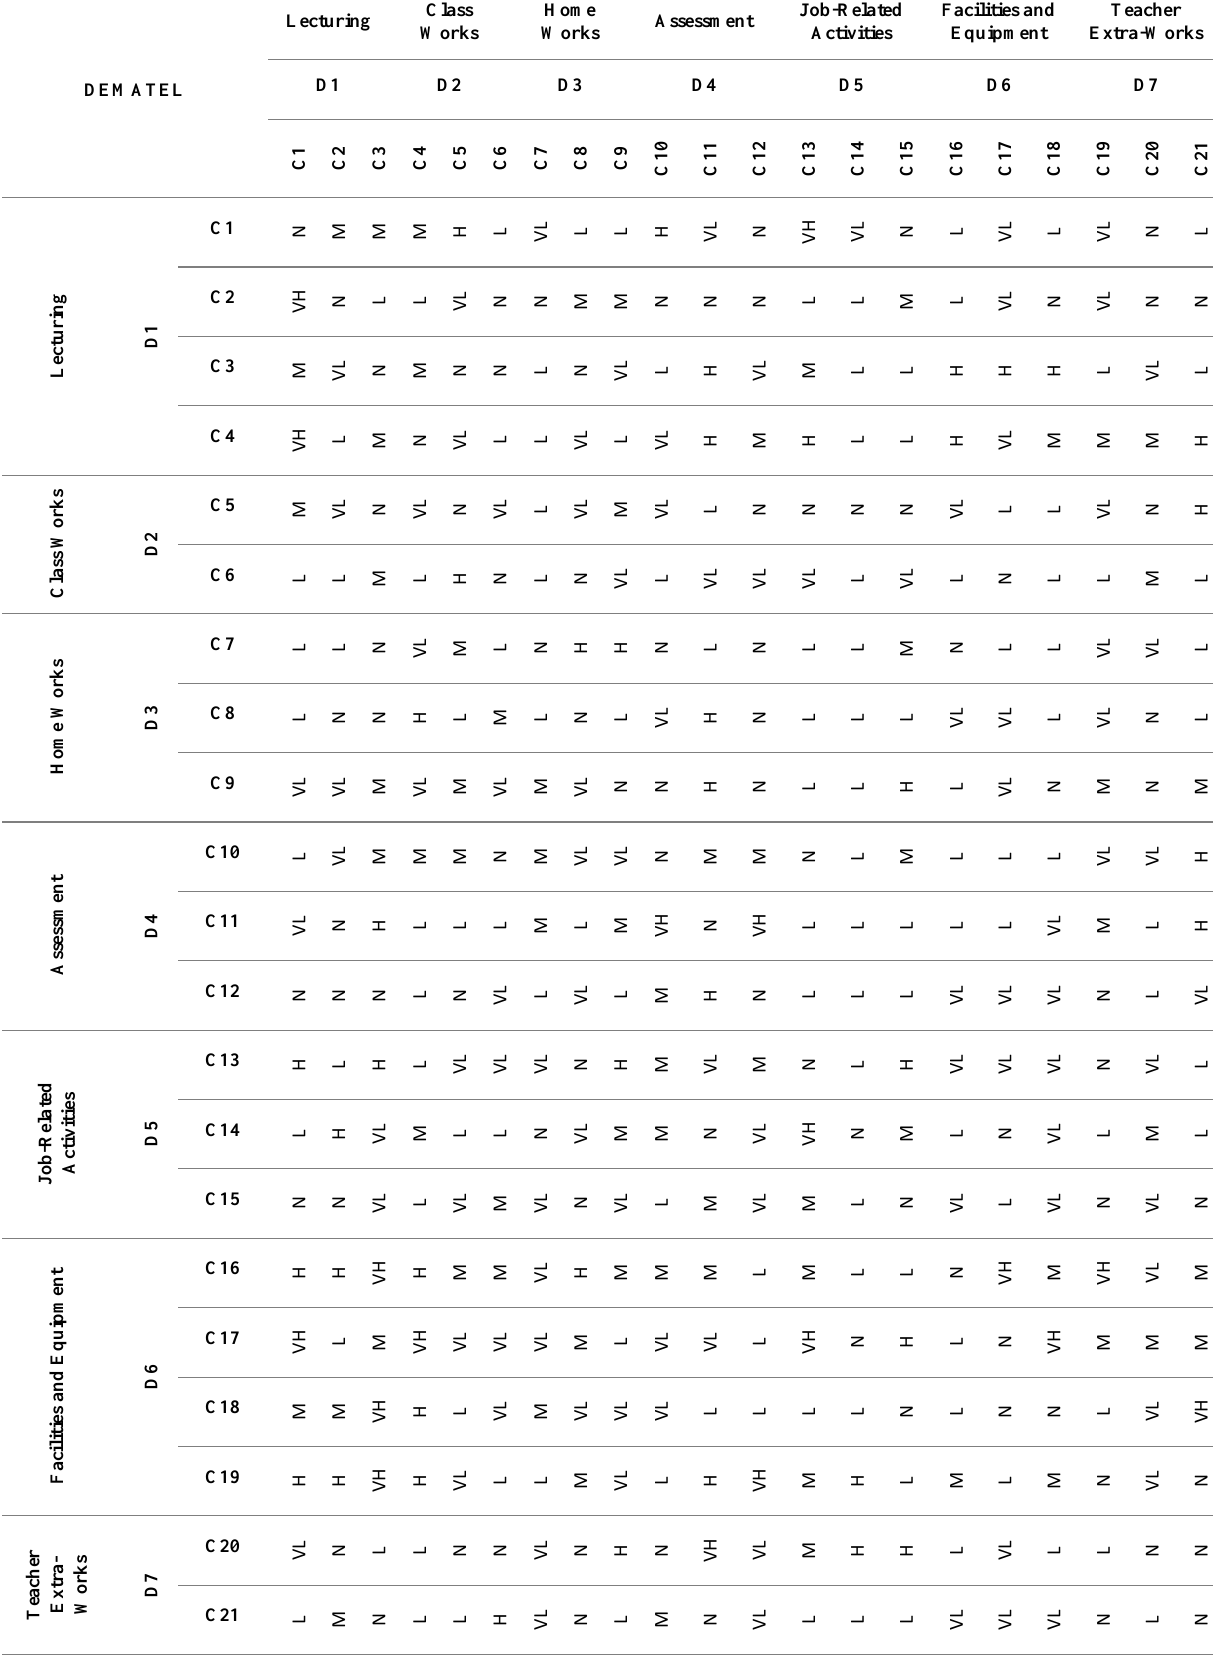
Table 4. An example of a direct influence matrix completed by experts using linguistic fuzzy phrases.